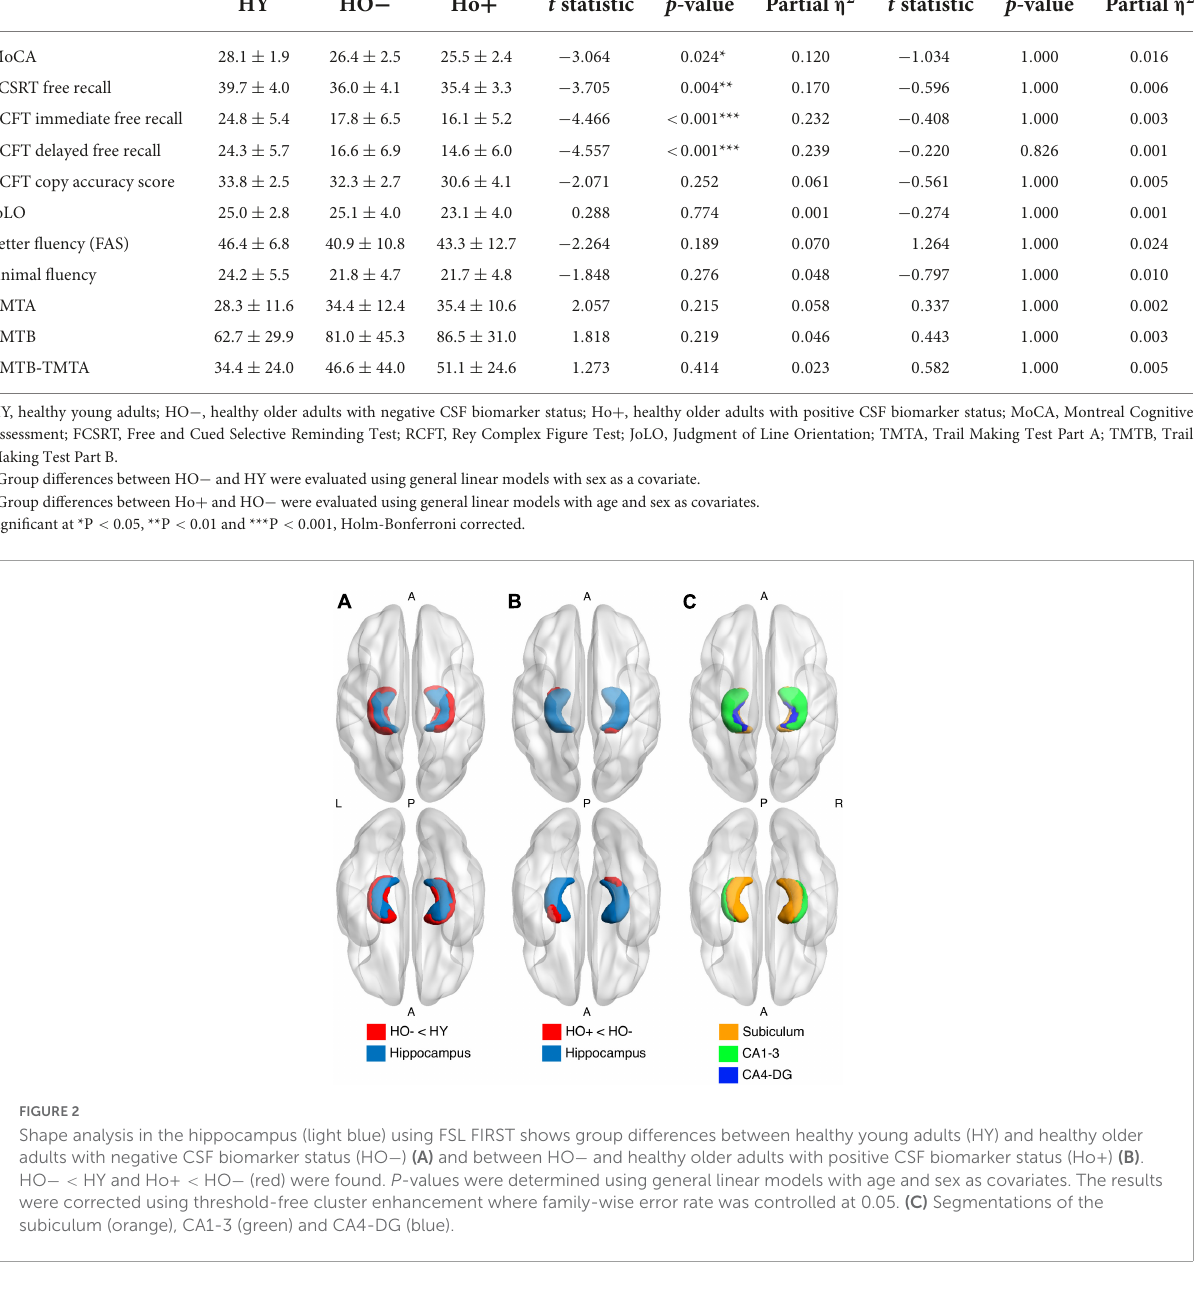
Holm-Bonferroni corrected, partial η 2 = 0.175] networks.